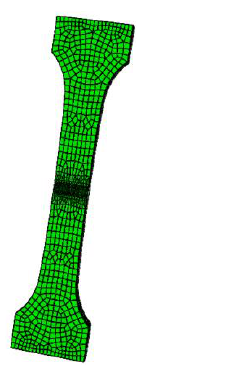
Figure 10. Specimen′s finite element model.